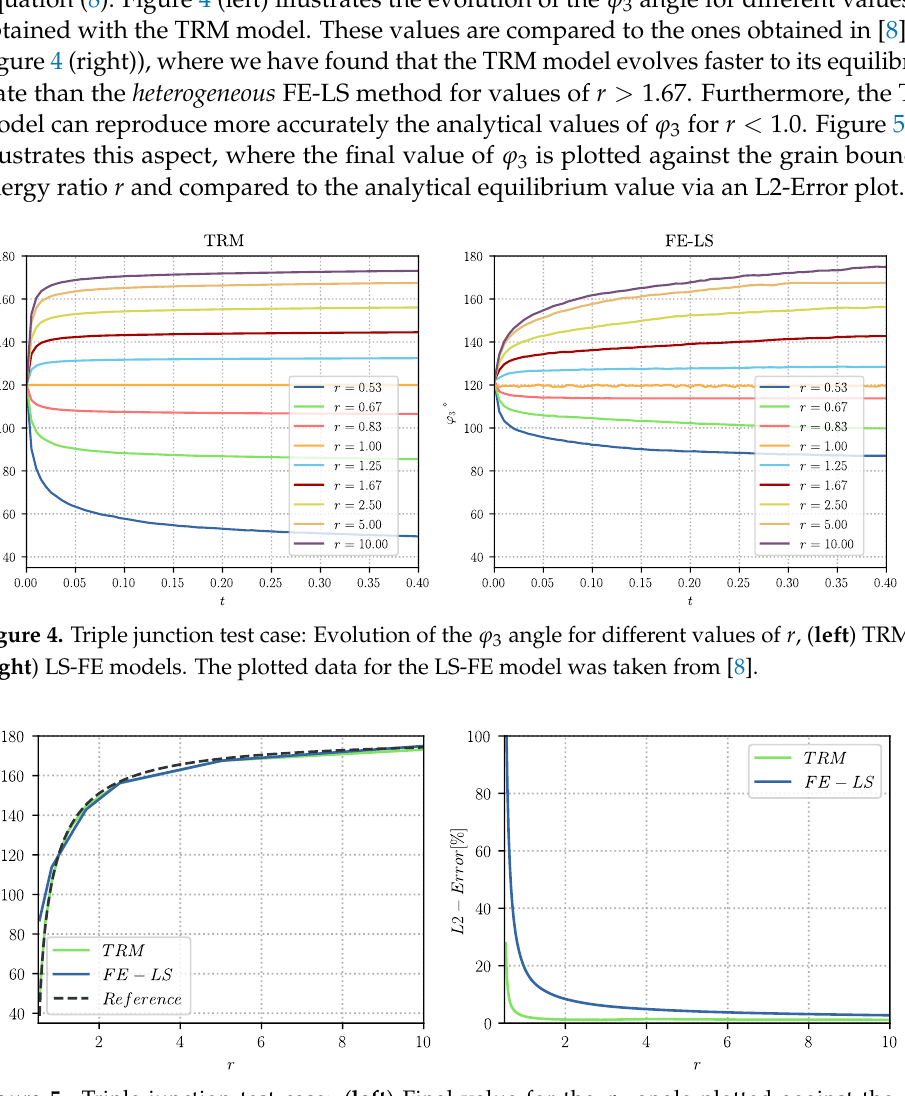
Figure 5. Triple junction test case: ( left ) Final value for the ϕ 3 angle plotted against the grain boundary energy ratio r and compared to the analytical equilibrium value, and ( right ) L2-Error. The plotted data for the LS-FE model was taken from